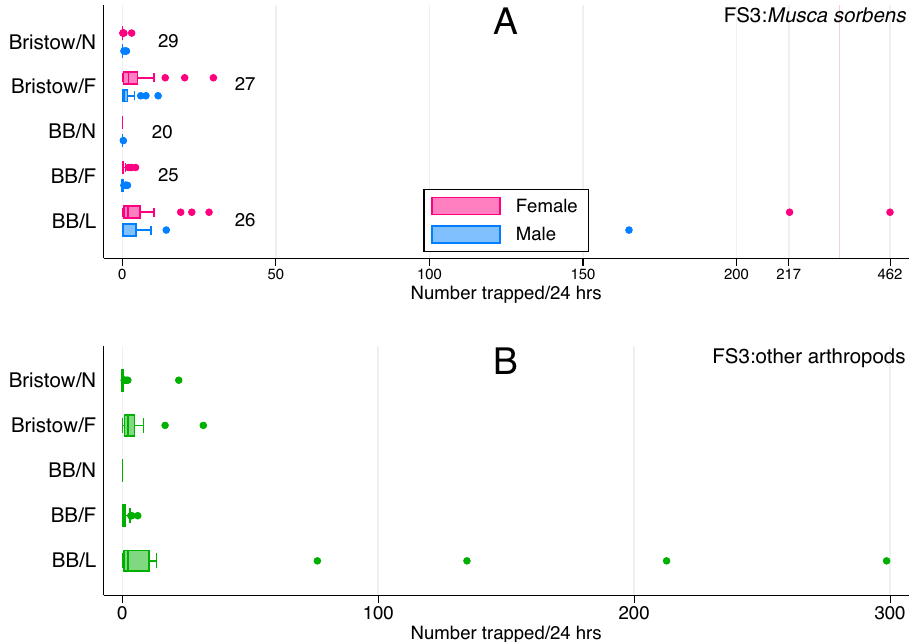
Figure 3. Male and female M. sorbens ( A ), and total ‘other arthropods’ ( B ) caught by different trap designs in field study 3 (FS3) (boxes, median and interquartile range; points, outliers). Trap abbreviations are: Bristow/N Bristow trap/no bait, Bristow/F Bristow trap/faeces bait, BB/N Bickford bucket/no lure (water), BB/F Bickford bucket/faeces bait, BB/L Bickford bucket/lure (Buzz). Trap events (3- or 4-day deployment) per trap type given as data labels in ( A ); those are equal for ( A / B